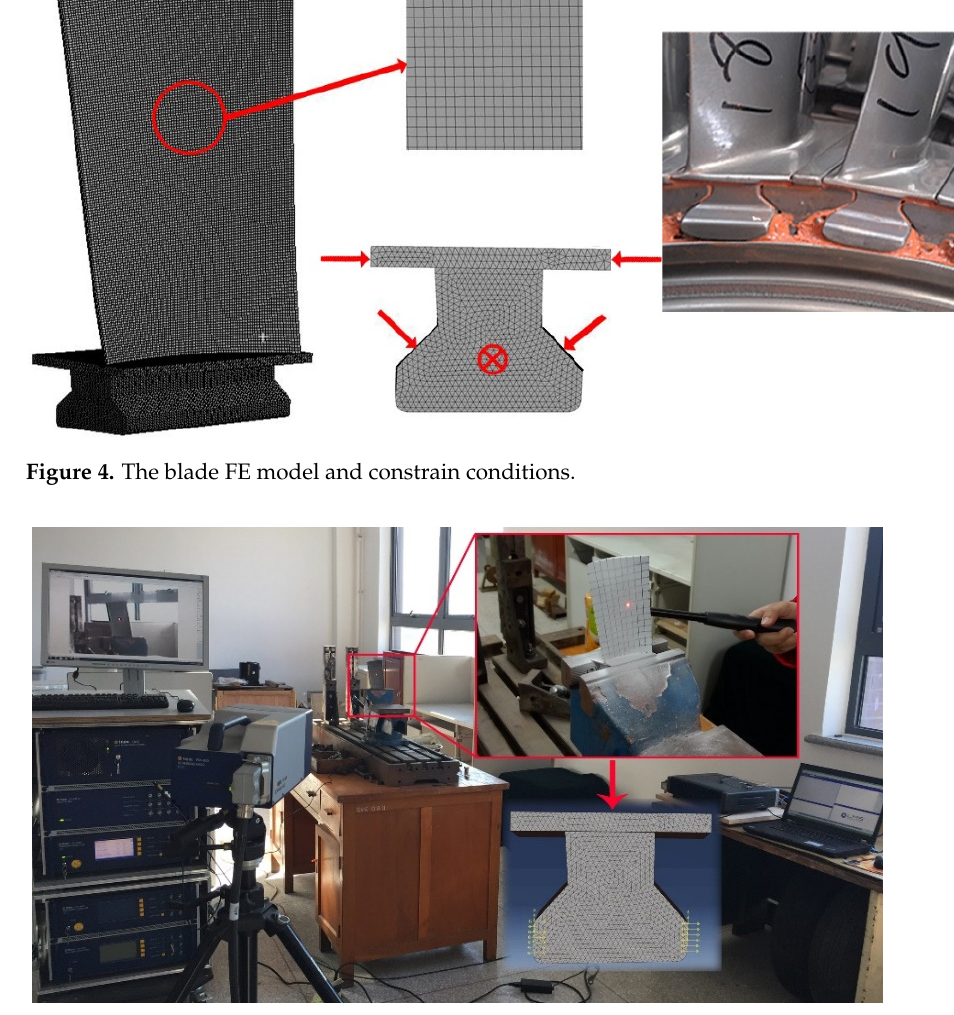
Figure 5. Modal test of the blade.